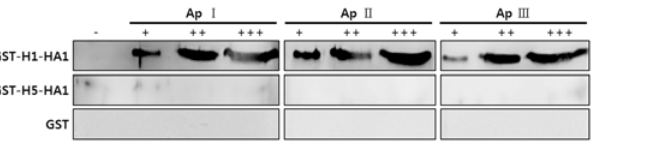
Fig 4. Western blot analysis using aptamers. Various amounts of GST-H1-HA1, GST-H5-HA1, and GST proteins were separated by SDS-PAGE, incubated with 5 0 -biotinylated aptamers, detected by streptavidin- HRP and ECL visualization ( − , 0 μ g; +, 1 μ g; ++, 5 μ g; +++, 10 μ g).